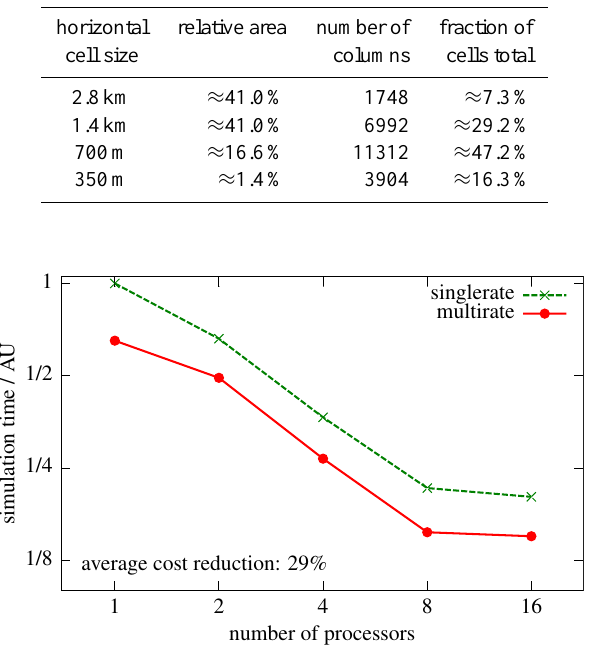
Fig. 9. Computational cost for realistic test case. The displayed sim-